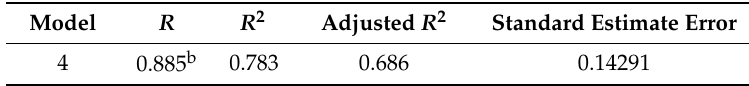
Table 4. Model summary a .